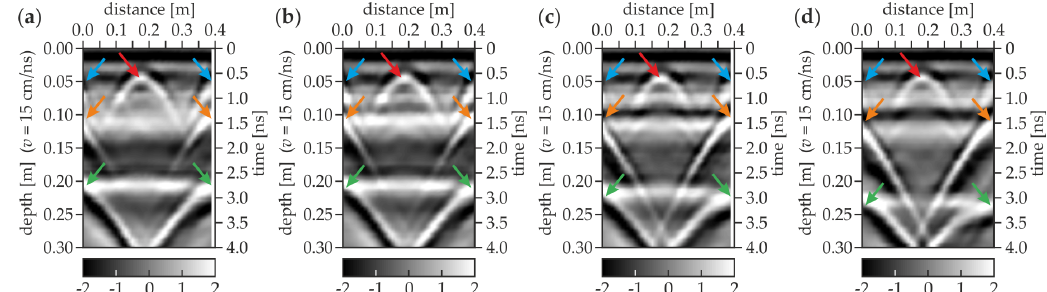
Figure 11. Experimental GPR B ‐ scans for concrete slabs with air gap of thicknesses ( a ) 1 mm (trace D ‐ 1); ( b ) 4 mm (trace D ‐ 2); ( c ) 20 mm (trace D ‐ 3); and ( d ) 50 mm (trace D ‐ 4).